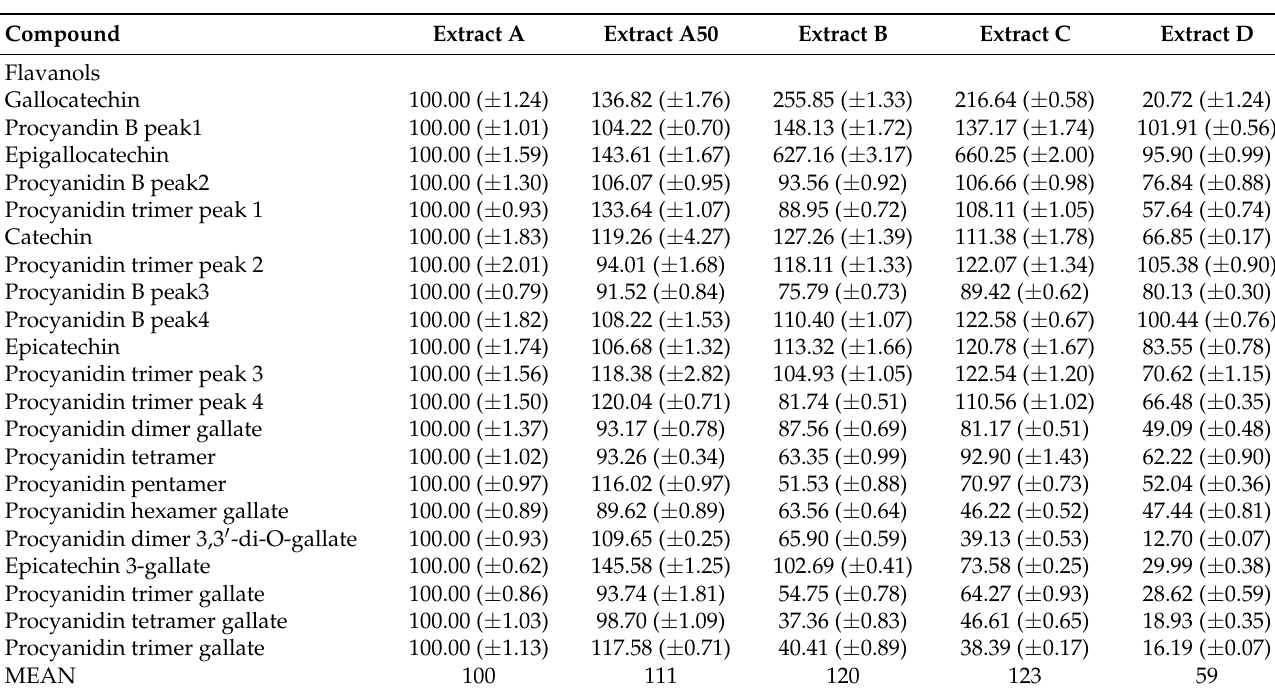
Table 8. Relative percentage (mean ± SD) of each flavanol in extracts A50, B, C and D calculated in respect to the content determined in extract A and set as 100%. The relative percentages were calculated by measuring the areas of the peaks reconstituted by setting the [M-H] − as filter ions.